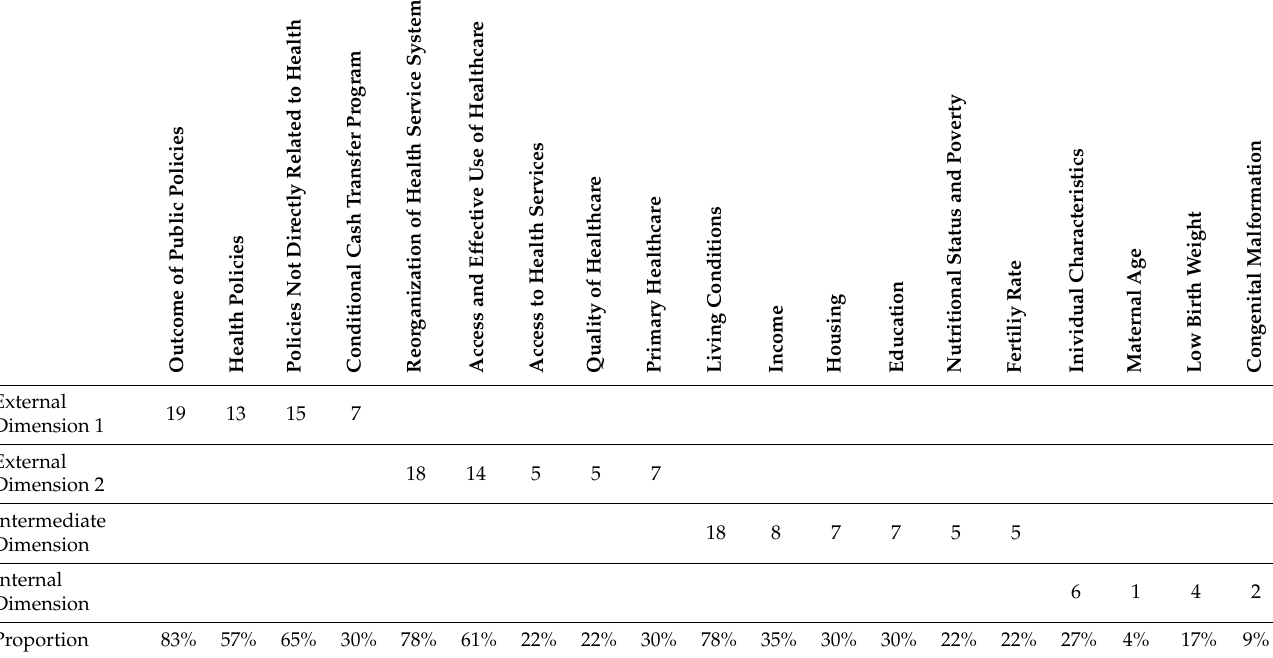
Table 3. Frequency and classification of determinants of infant mortality according to the